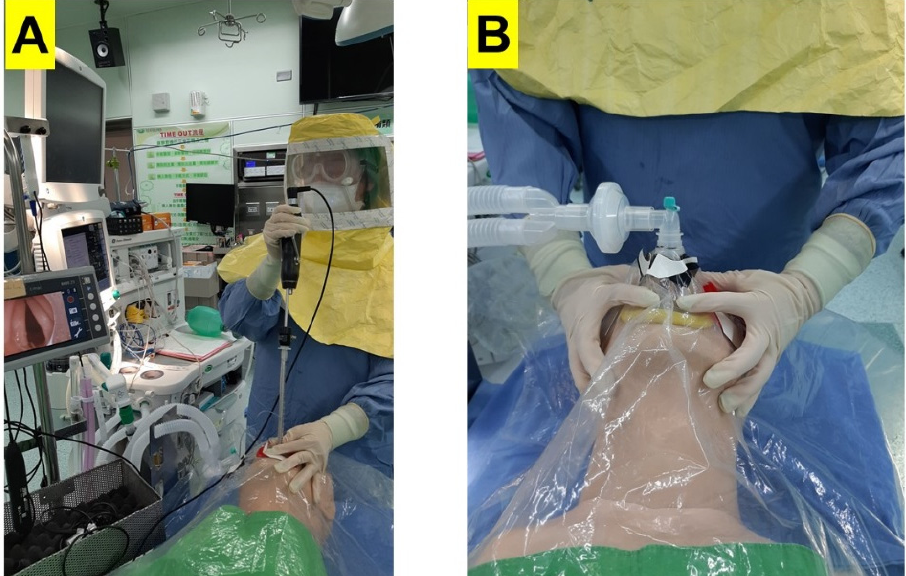
Figure 13. Two crosscuts are made into the plastic barrier sheet to allow ( A ) endotracheal intubation using a video-assisted intubating stylet, while ( B ) the second crosscut in the plastic barrier allows timely resumption of mask ventilation if the need arises during the intubation attempt. (Courtesy photo reproduced from Asian Journal of Anesthesiology [40] with per- mission).